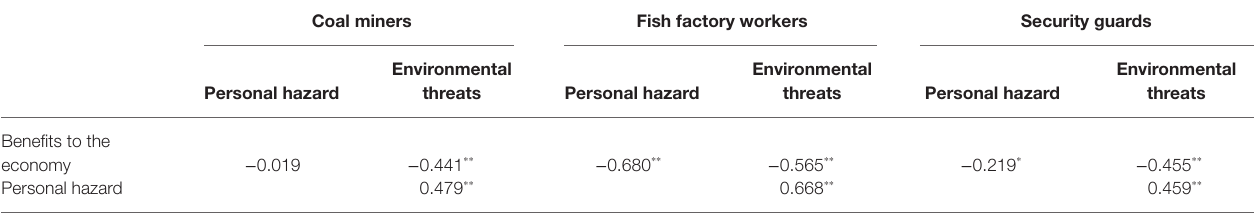
TABLE 2 | Correlations among the three measures in a sample across the three groups. Coal